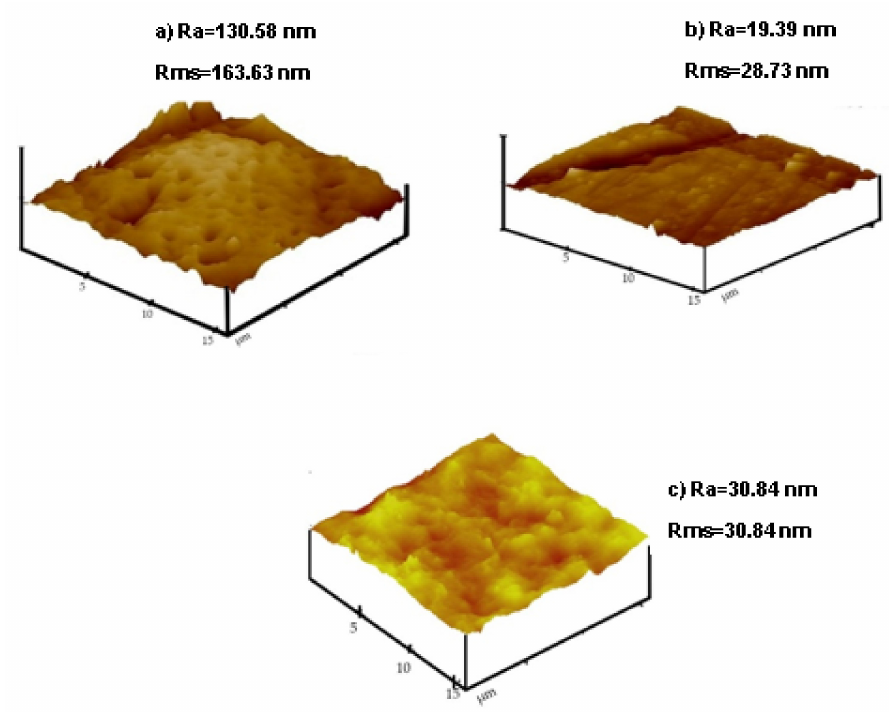
Figure 6. AFM images with surface roughness values ( a ) 0 wt.% SSOD/PSF, ( b ) 5 wt.% SSOD/PSF and ( c ) 10 wt.%